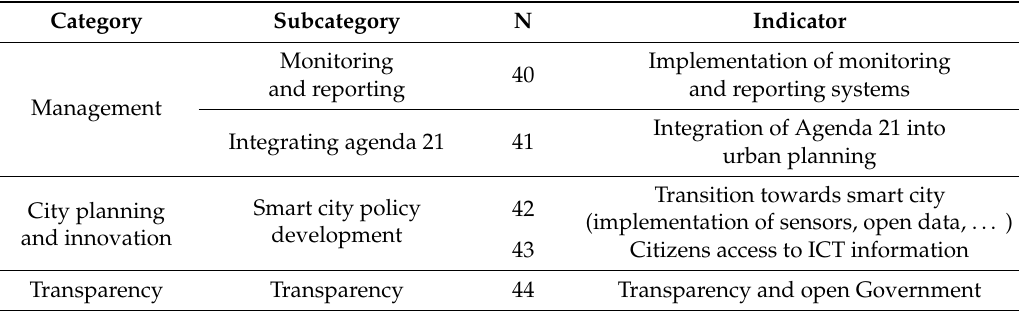
Table 6. Proposed indicators for governance aspects.